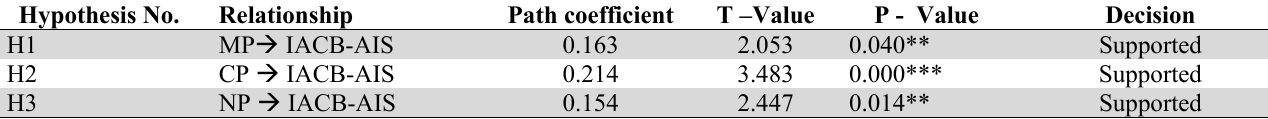
Result of Hypotheses Testing of the Direct Relationship Model Hypothesis